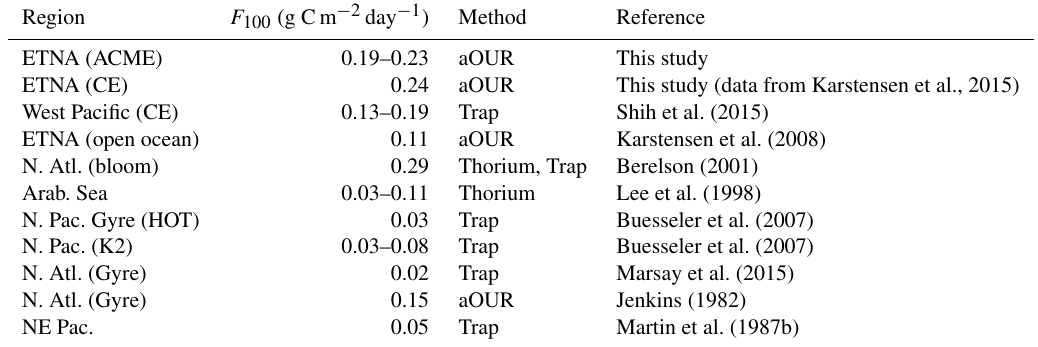
Table 2. Comparison of F 100 values from the literature representing different ocean regions with the results of this study.